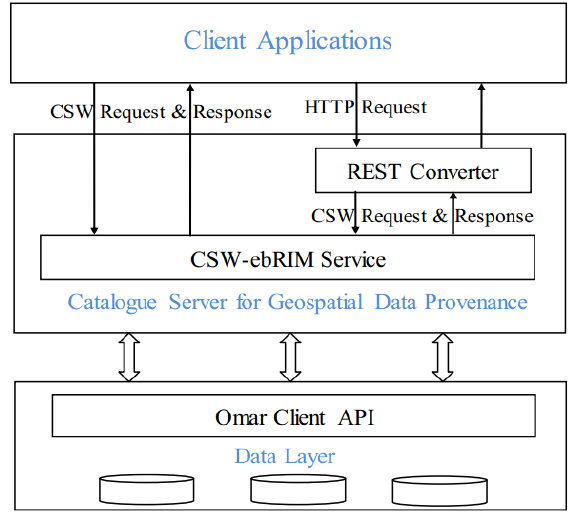
Figure 1. Architecture of RESTful geospatial provenance